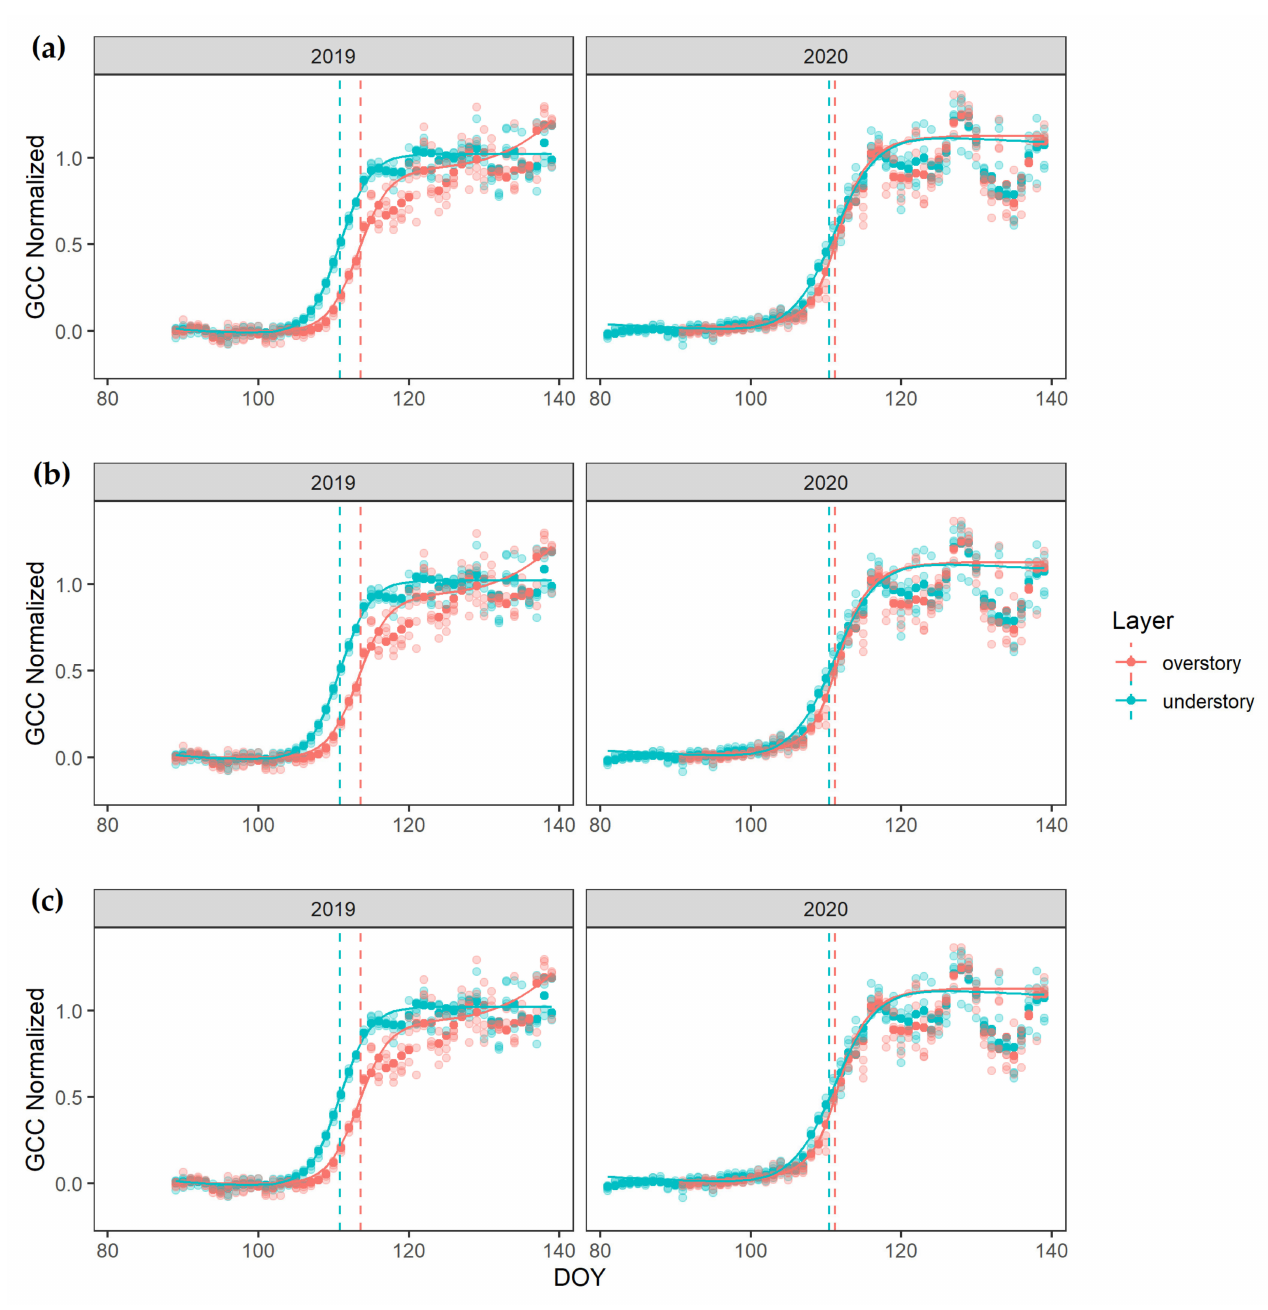
Figure A1. All camera observed normalized GGC time series for the three different sites ( a – c ) from quadrant Q4, with the two years separated over two panels. Transparent symbols indicate GCC values from hourly camera pictures (four per day). Opaque symbols represent the 60th percentile of a 3 day moving window and a time step of 1 day. Each curve represents modelled values for one camera × year resulting from double-logistic functions to each time series according to Beck et al. [57]. Vertical dashed lines indicate start of season (SOS), the DOY at which a normalized GCC of 0.5 was reached for the modelled values. Red represents overstory, while blue represents